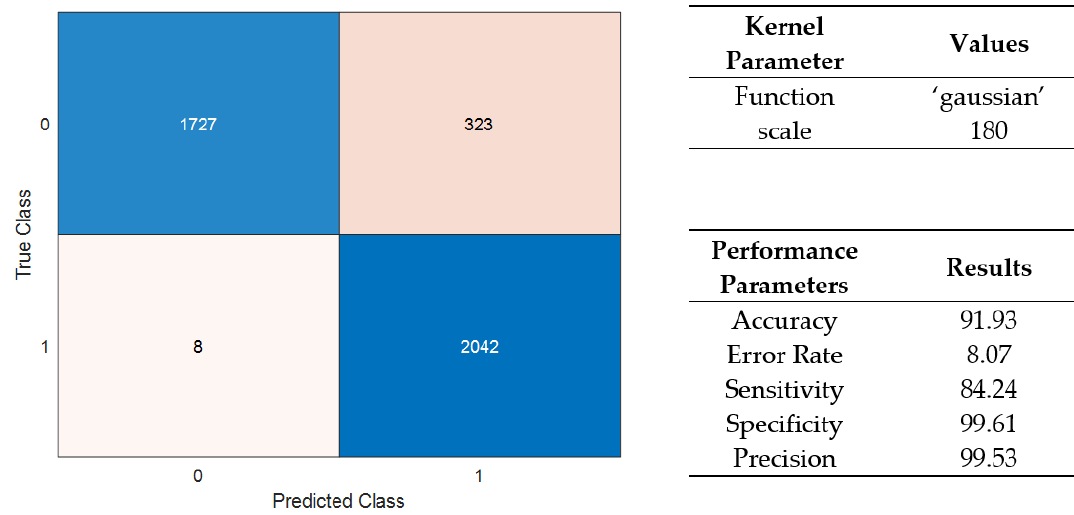
Figure 14. Confusion matrix and performance results for a Gaussian kernel with coarser spacing.